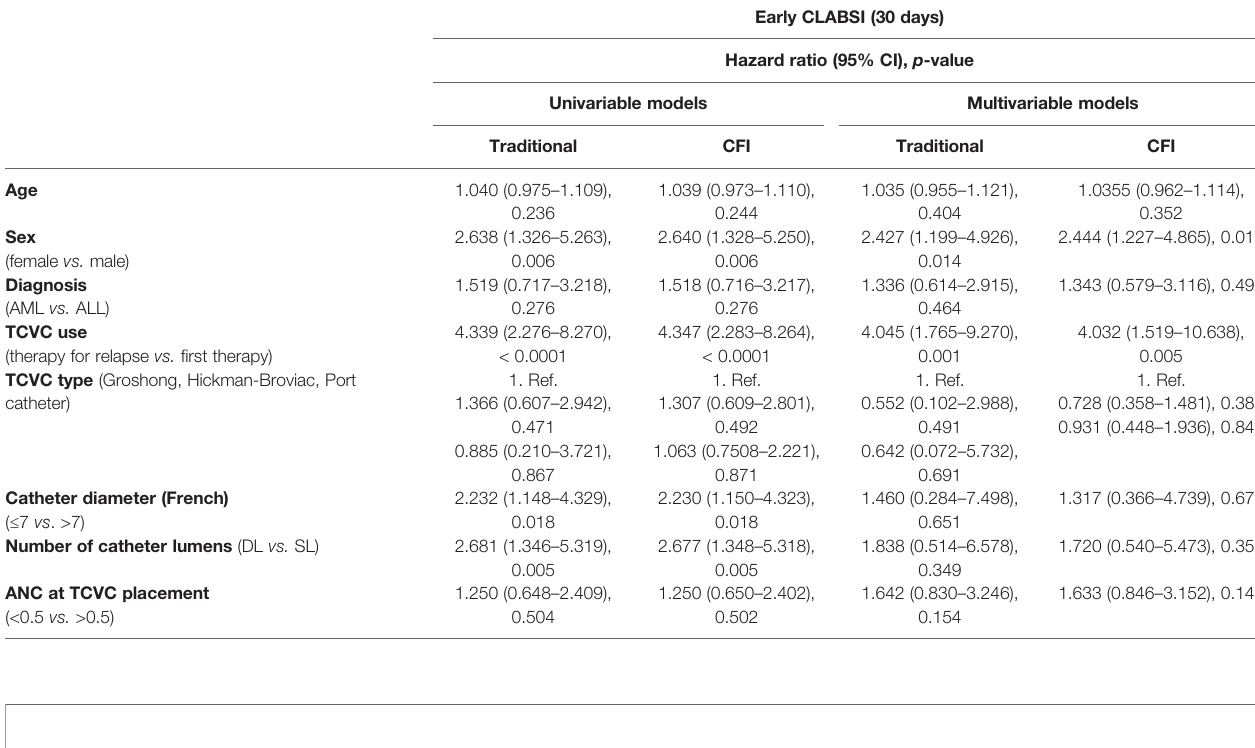
TABLE 2 | Univariable and multivariable regression analysis for primary